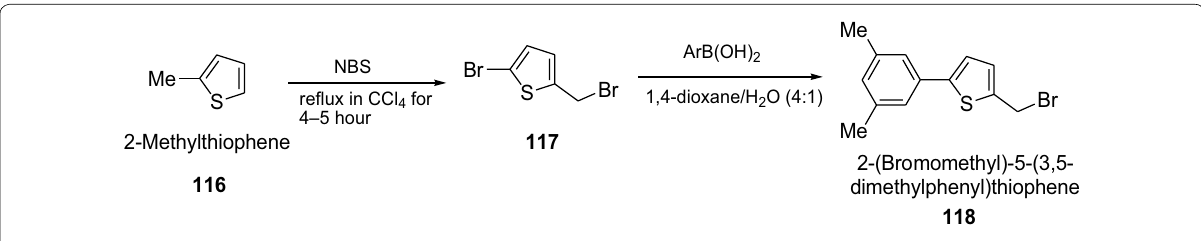
The results are average S.D of triplicate experiments p < ± the micro-centrifuge tubes containing venous blood, and incubated at 37 °C for 45 min. Streptokinase was used as standard clot lysis agent and water as negative control for this assay. Among all the synthesized compounds, 118 showed potent clot lysis (31.5%). However, the results were significant p < 0.05, when compared with streptoki- nase. Clot lysis activity results are presented in Table 26.